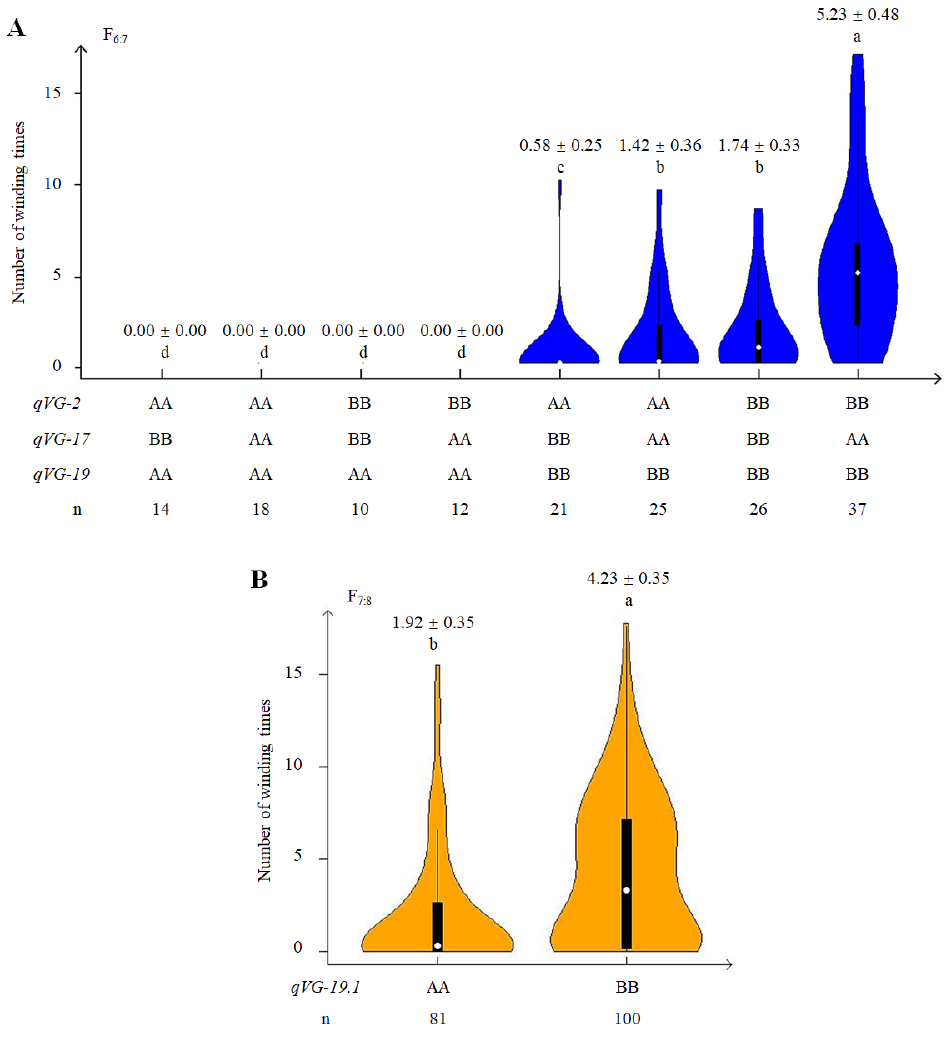
Figure 4. Vining growth of soybean lines with different alleles at related QTLs. ( A ) Violin plots show the VG of RIL families carrying various allele combinations at three QTLs ( qVG-2 , qVG-17 and qVG-19 ) in the ZH39 × NY27-38 population. ( B ) Violin plots of the VG of RIL families (derived from the ZH39 × NY36-87 cross) carrying parental genic alleles at qVG-19.1 . AA and BB represent alleles from the Glycine max and G. soja parents, respectively, at the corresponding SSR loci. Box and whisker plots are shown in each violin plot; the white node in the center indicates the median. Different letters above the plots indicate significant differences between the lines with different genotypes (one-way ANOVA followed by Fisher’s test, p <